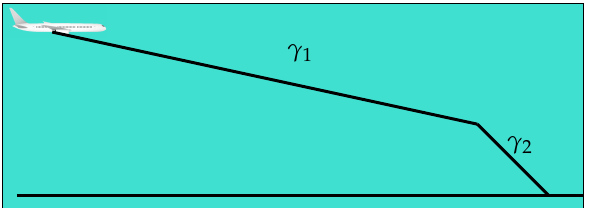
Figure 5. Example of descent profile: γ 1 corresponds to the minimal descent angle (Maximal lift-to- drag ratio) and γ 2 is the descent angle during the approach phase.